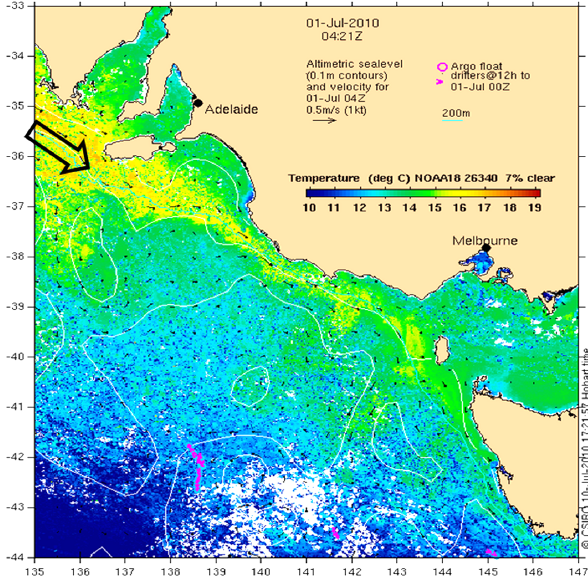
Figure 5. Time series (1 January 1998 to 31 December 2000) of satellite-derived data of (a) OC4 (mgm − 3 ) , (b) sea surface tem- perature (SST, ◦ C) for the Bonney coast and the western Tasma- nian shelf, and (c) discharge from the Davey River (m 3 s − 1 ). Run- ning averages over an interval of 24 days have been used for both OC4 and river discharge. A running average over 20 days has been applied to the SST data. Shaded areas of panel (a) highlight peri- ods of substantial differences between the time series. Shaded ar- eas in panel (b) denote intermittent warming created by the South Australian Current. Stars highlight an upwelling event in early Jan- uary 2000, corresponding to the spatial distributions shown in in Fig. 3. Data source: SEF ocean movies, David Griffin, CSIRO, Aus- tralia.